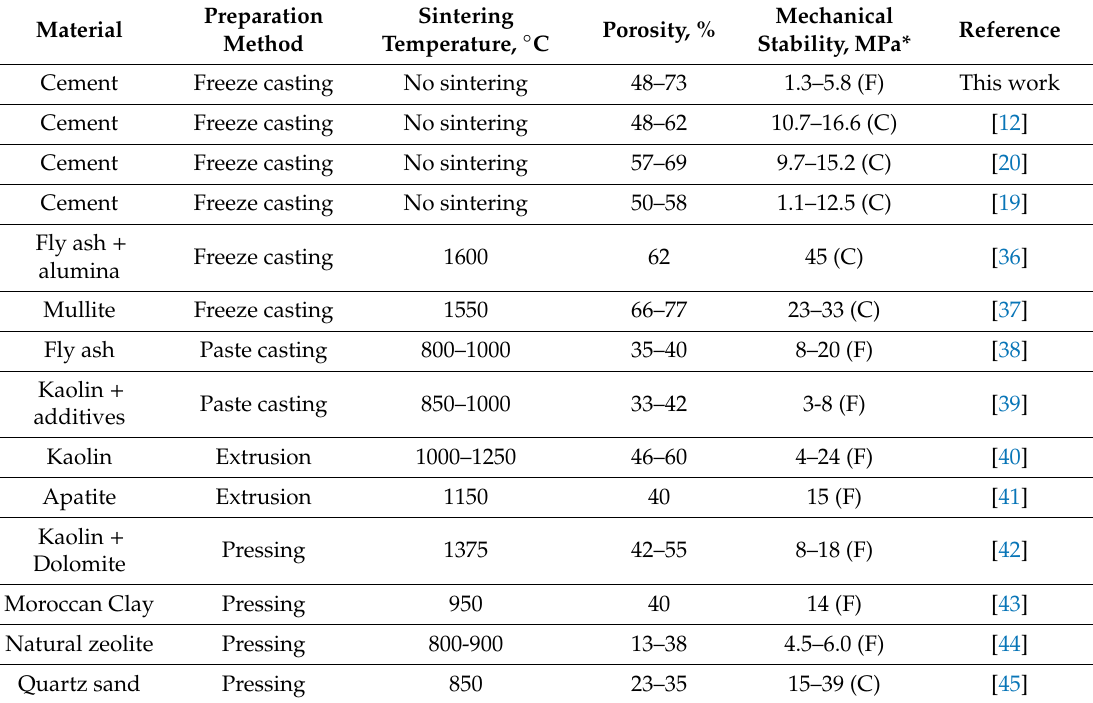
Table 2. Porosity and mechanical stability of low-cost membrane supports.